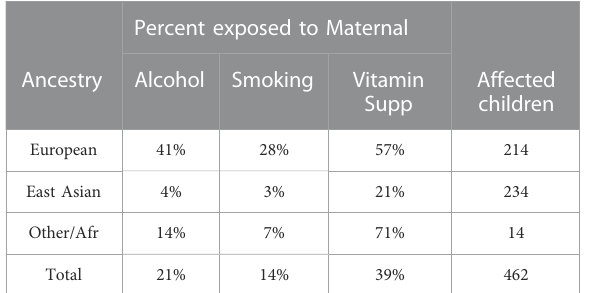
TABLE 5 Exposure rates for maternal alcohol consumption, maternal smoking and maternal vitamin supplementation by self-reported ancestry in affected trios.